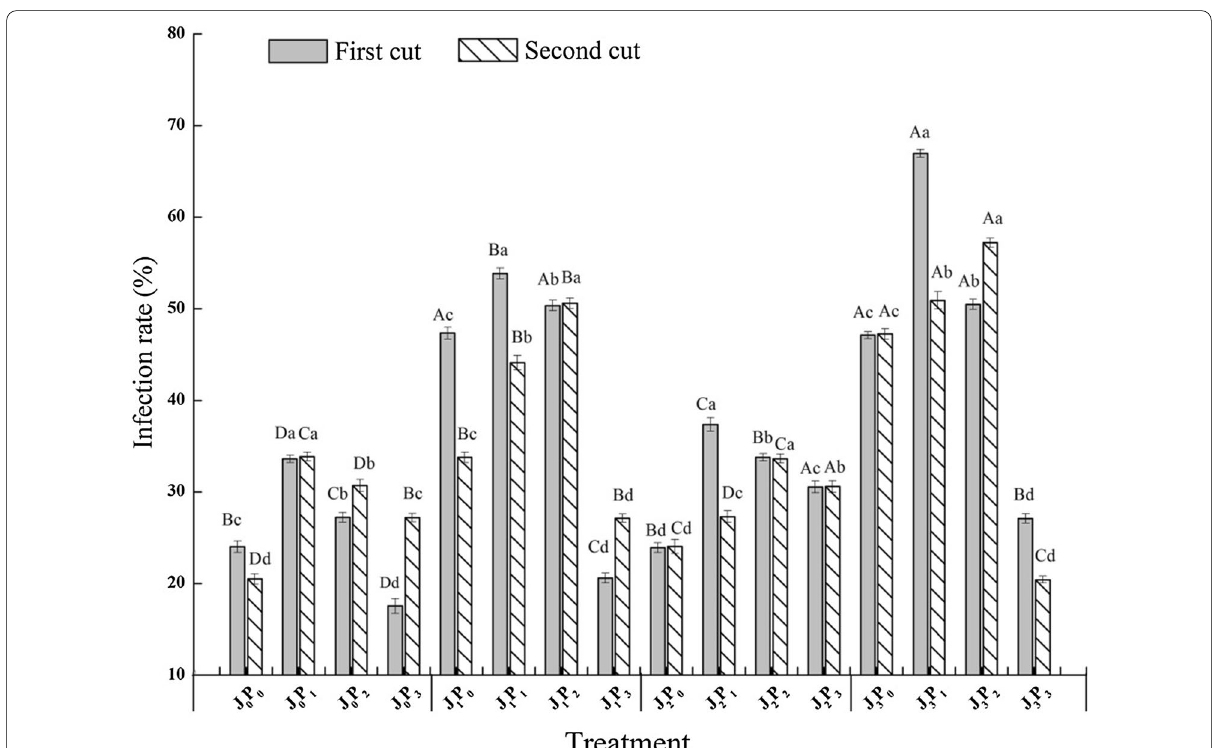
Fig. 1 Mycorrhizal infection rate of alfalfa inoculated with AMF and PSB under different phosphorus application conditions. Different capital letters indicated significant difference in different bacteria treatments under the same phosphorus application conditions( P < 0.05), differences small letters mean significant difference under the same bacteria treatments( P < 0.05). P 0 , P 1 , P 2 , and P 3 represent 0 mg kg − 1 , 50 mg kg − 1 , 100 mg kg − 1 , and 150 mg P kg − 1 , respectively. J 0 , J 1 , J 2 , and J 3 represent CK, Fm, Bm, and Fm Bm, ×